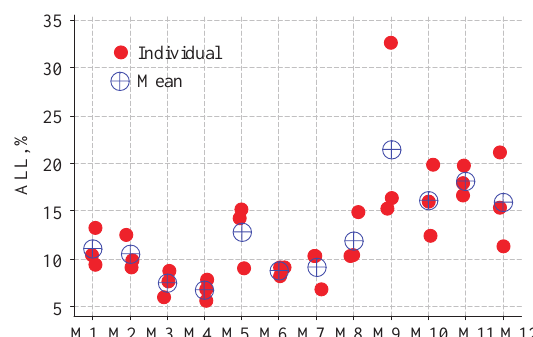
Fig. 7. Results of ALL tests on all 12